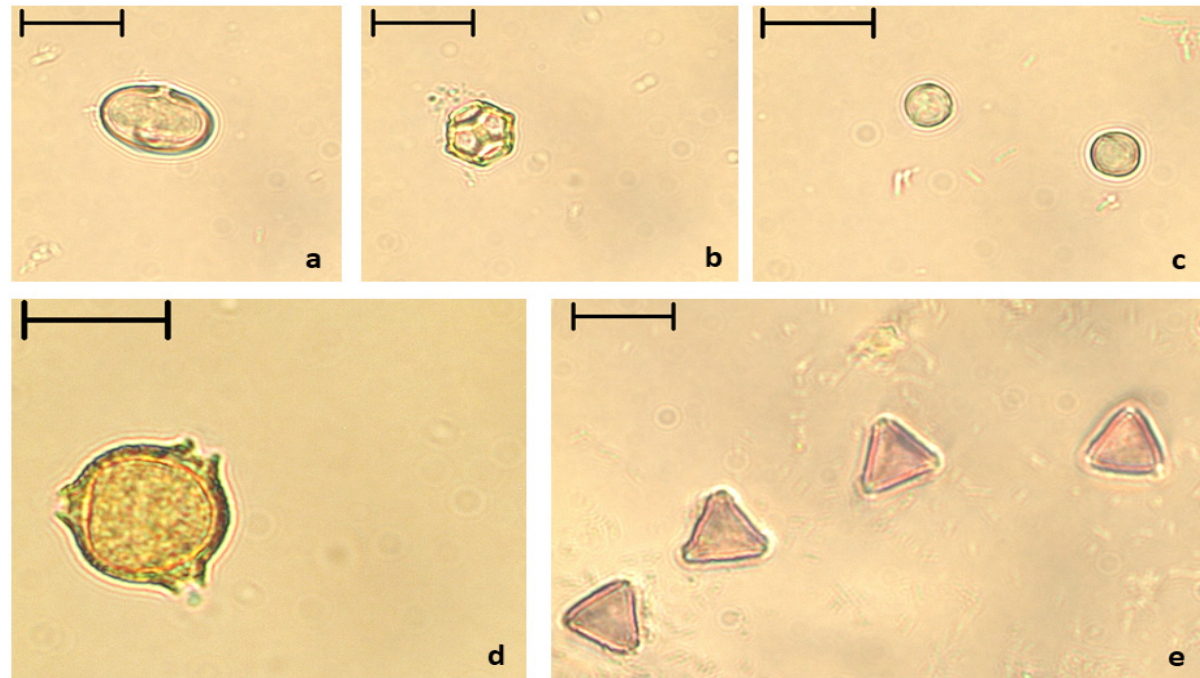
Fig 2 . Pollen grains of the prevailing types identified in the stingless bee honey and pollen samples of both provinces seen with a magnification